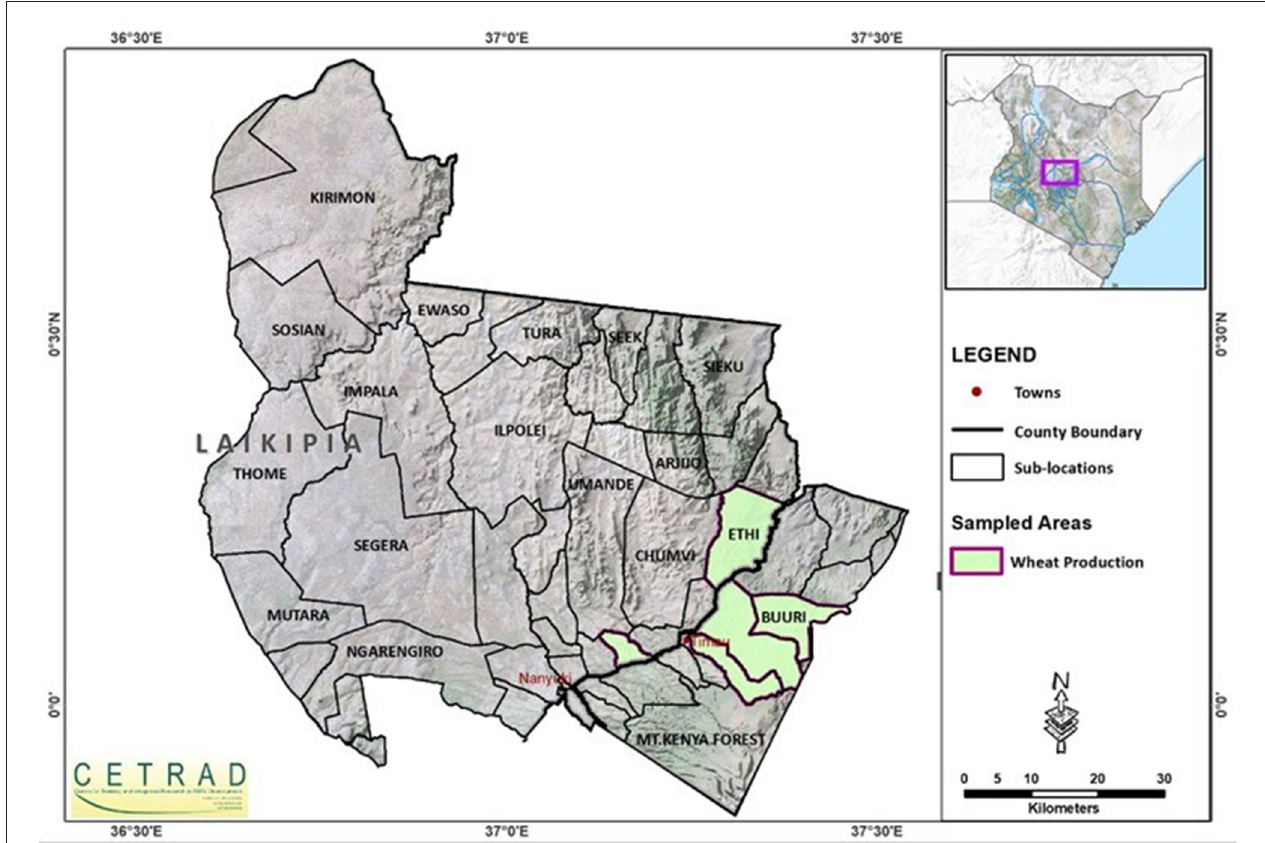
FIGURE 1 | The study area showing sampled sub-locations (Source: Centre for Training and Integrated Research in ASAL Development).